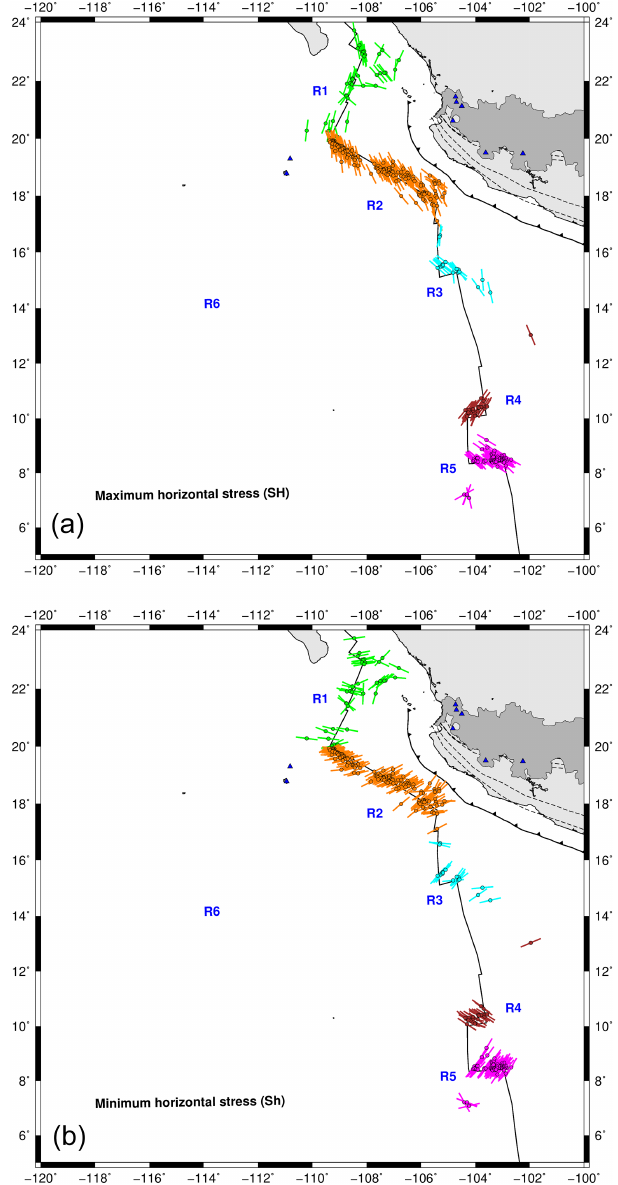
Figure 8. Orientation of horizontal axes. (a) Maximum horizontal stresses (SH); (b) Minimum horizontal stresses